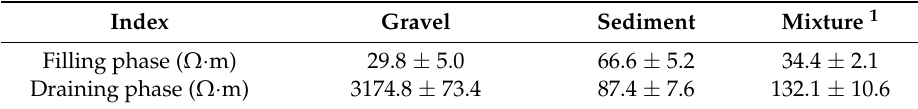
Table 2. Apparent resistivities of wetland mediums.